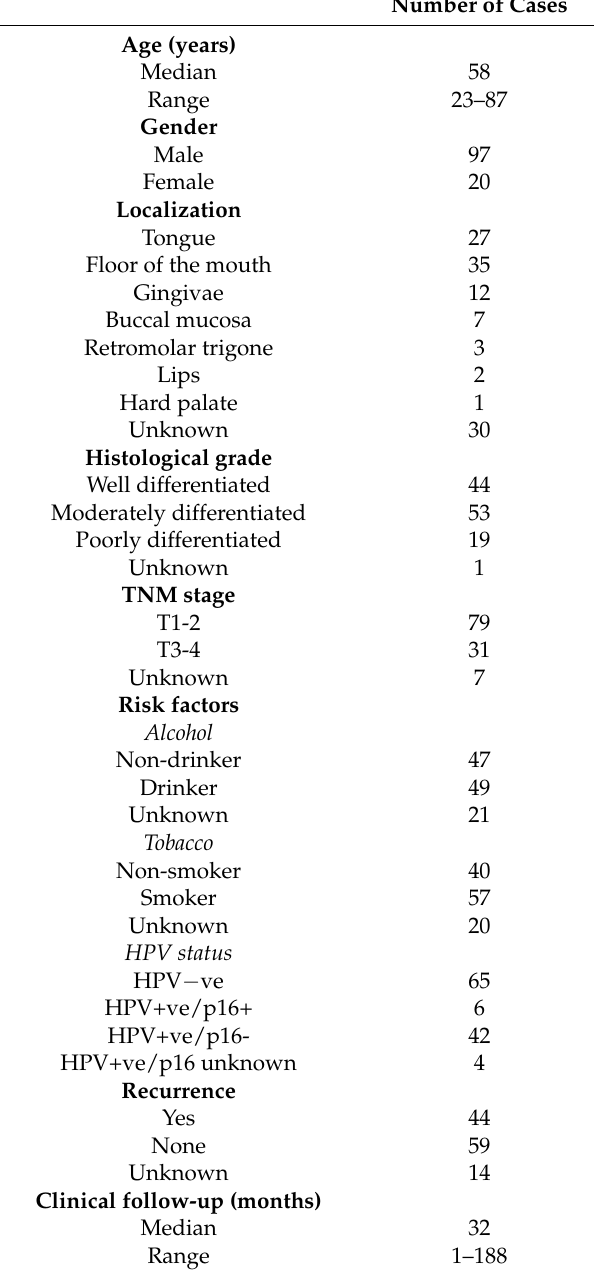
Table 2. Oral cavity cancer patients’